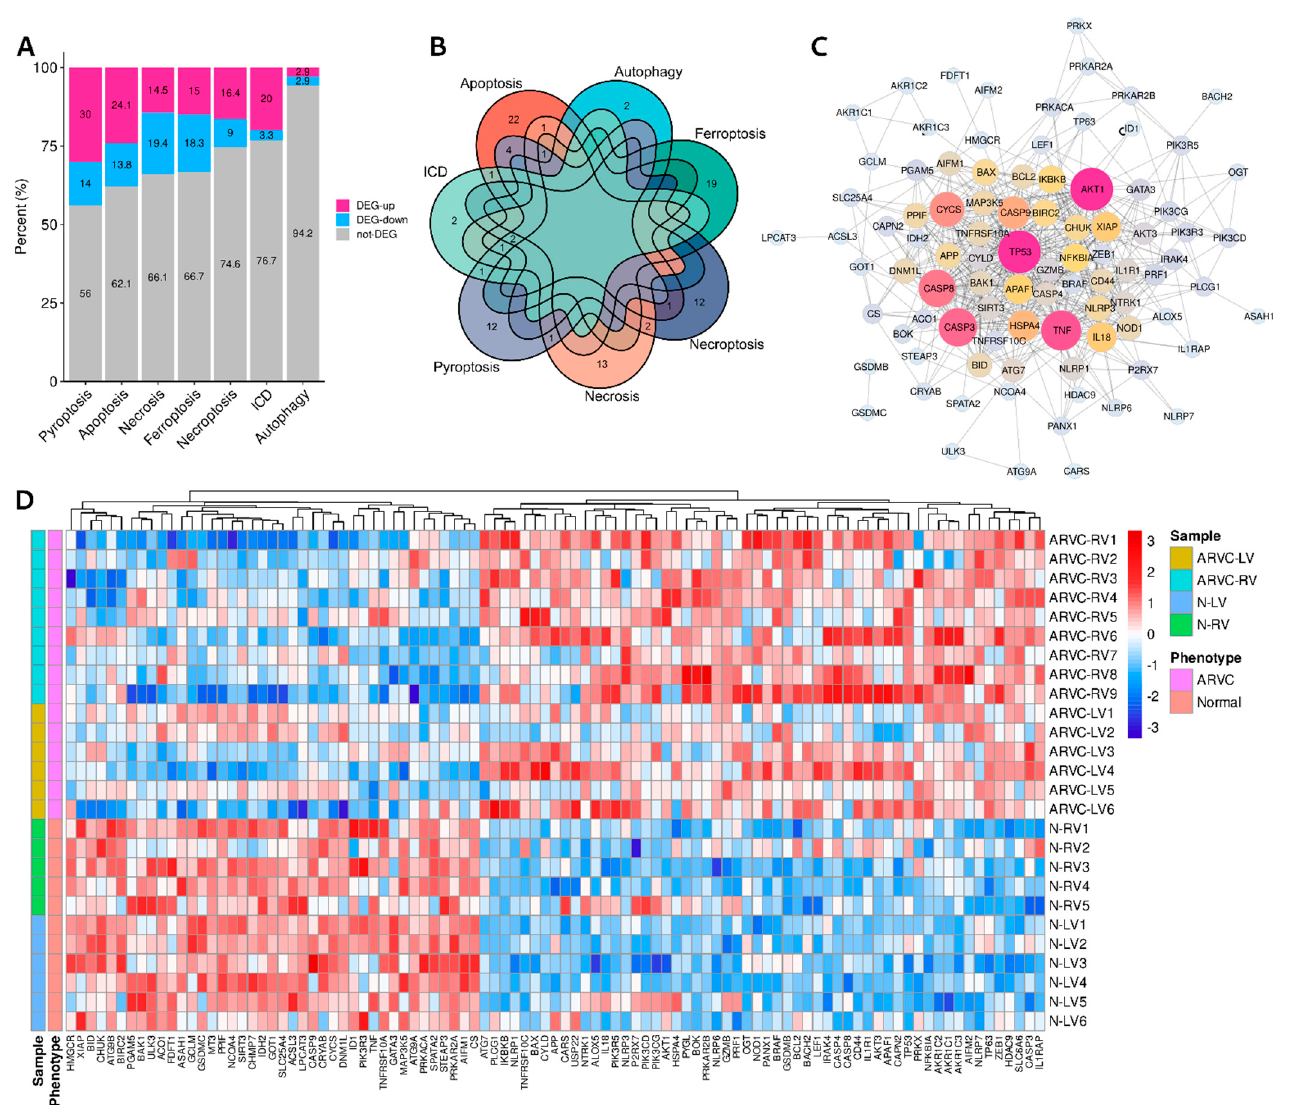
Figure 1. Differentially expressed cell death signature genes (CD-DEGs). ( A ): Proportions of the up-regulated and down-regulated CD-DEGs. ( B ): Overlaps of the CD-DEGs. ( C ): Protein–protein interaction network of the CD-DEGs. ( D ): A heatmap shows the CD-DEGs between ARVC samples and normal controls. ARVC, arrhythmogenic right ventricular cardiomyopathy; ARVC-LV/RV, left/right ventricular myocardial samples from ARVC patients; N-LV/RV, left/right ventricular myocardial samples from normal controls; ICD, immunogenic cell death.